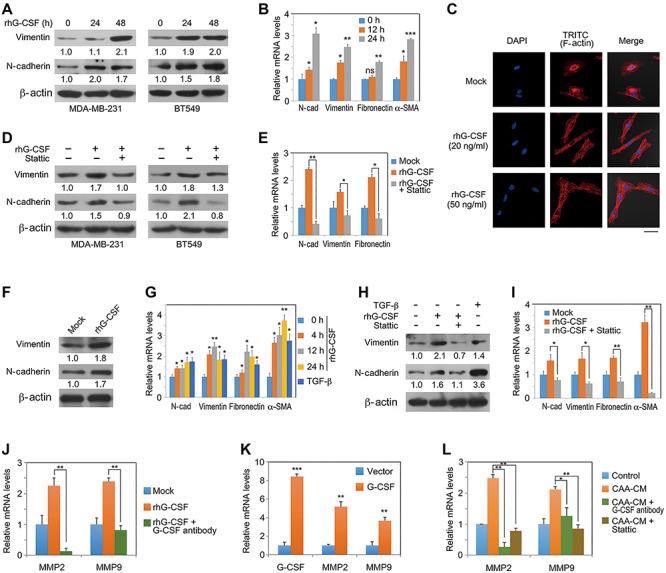
G-CSF promotes EMT of breast cancer cells. (A and B) TNBC cells were treated with or without 20 ng/ml rhG-CSF in 2% FBS-containing DMEM for the indicated time periods. Protein expression levels in MDA-MD-231 and BT549 cells (A) and mRNA levels in MDA-MB-231 cells (B) were detected, respectively. Protein expression levels were quantified with Image J and normalized to that of the loading control (β-actin). (C) MDA-MB-231 cells treated with G-CSF (20 or 50 ng/ml) for 24 h were stained with TRITC-labelled phalloidin. Scale bar, 40 μm. (D and E) MDA-MB-231 cells were treated with rhG-CSF (20 ng/ml) and Stattic (20 μg/ml) as indicated for 48 h. Protein (D) and mRNA (E) expression levels were determined. (F and G) NMuMG cells were treated with 20 ng/ml rhG-CSF for 48 h before western blotting (F) or for the indicated time periods before q-PCR (G). TGF-β1 ligand stimulation for 4 h served as a positive control in q-PCR analysis. (H and I) Stattic inhibits rhG-CSF-induced mesenchymal marker expression in NMuMG cells. (J and K) Gene expression levels in MDA-MB-231 cells treated with 20 ng/ml rhG-CSF and 1 μg/ml anti-G-CSF antibody as indicated for 4 h (J) or stably expressing G-CSF or control vector (K). (L) MDA-MD-231 cells cultured in CAA-CM or control DMEM were treated with G-CSF-neutralizing antibody or Stattic as indicated for 4 h before q-PCR analysis. Typical microscopic fields and blots are shown and quantitative data are presented as mean ± SD from at least three independent experiments. *P < 0.05, **P < 0.01, ***P < 0.001, ns indicates not significant.